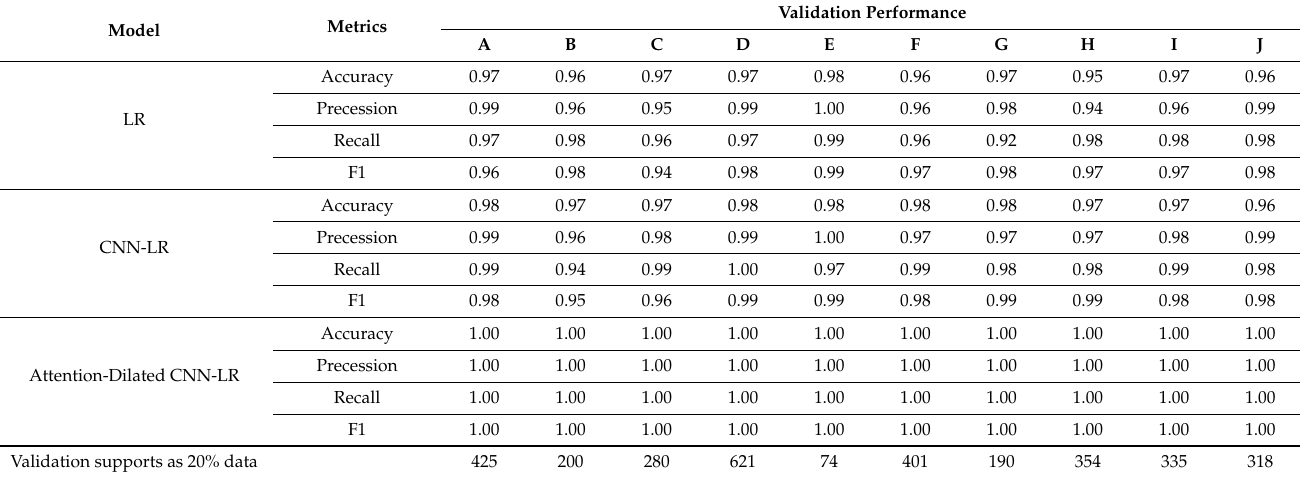
Table 4. Validation performance of ADCLR